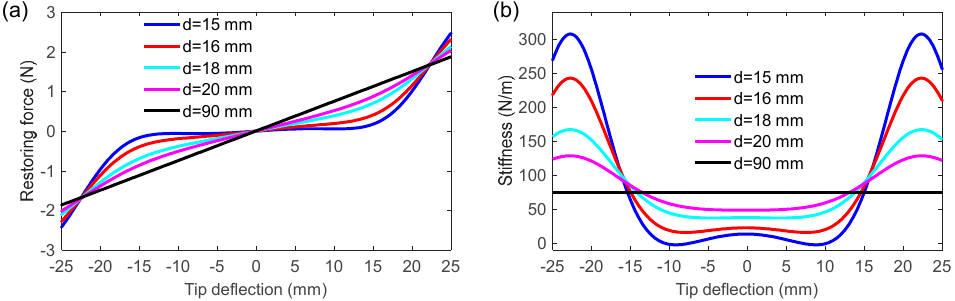
Figure 4. ( a ) Restoring force; ( b ) stiffness at various separation distances.